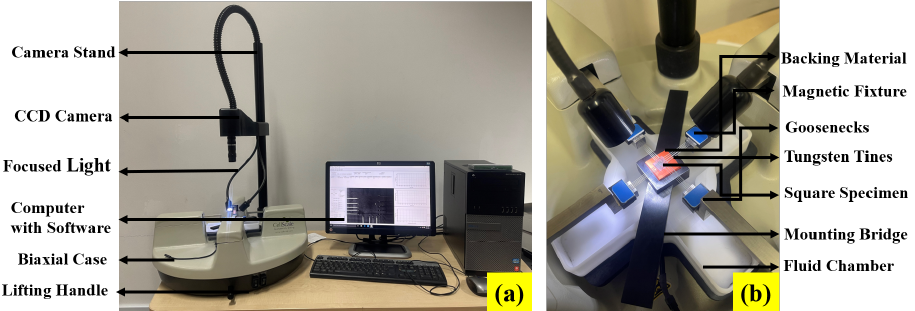
Figure 1. Representation of ( a ) Biaxial testing device and ( b ) enlarged view of the specimen holder for conducting uniaxial, pure shear, biaxial and equibiaxial test at a fixed strain rate [40].